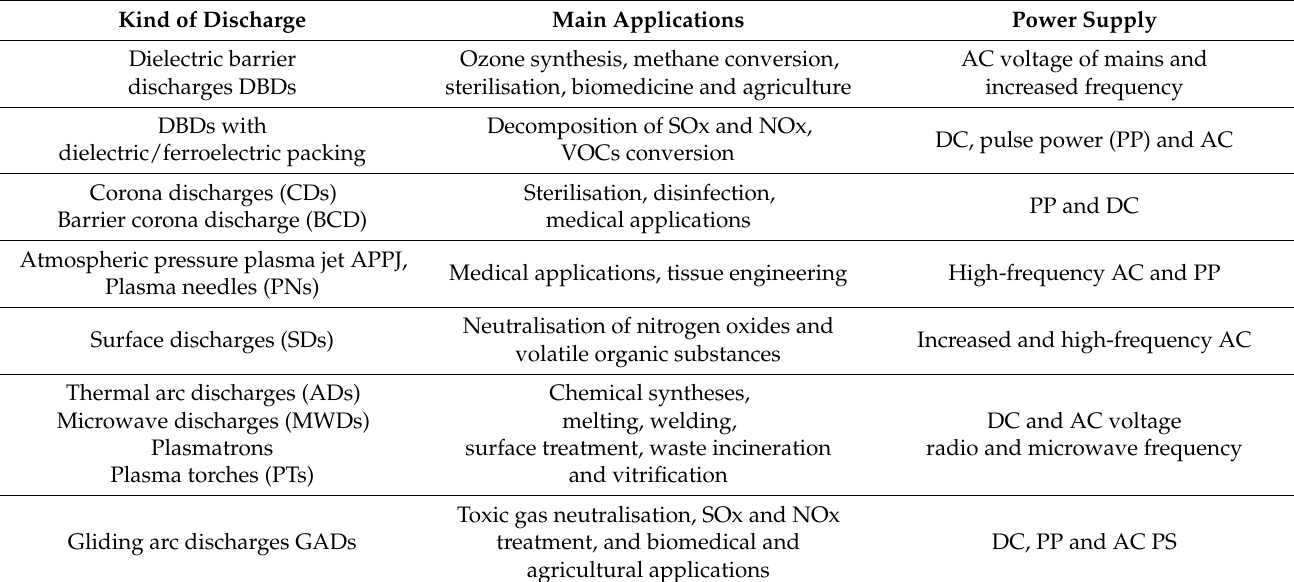
Table 2. Plasma reactors, their applications, and their power supply